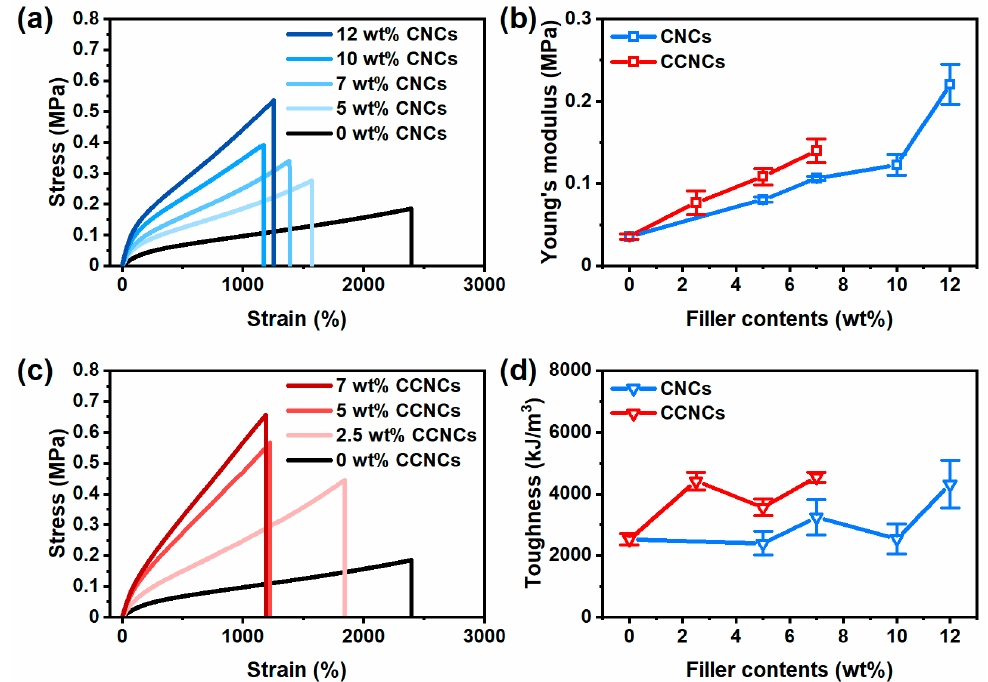
Figure 4. Mechanical properties of the nanocomposite hydrogels. ( a ) Tensile stress–strain curves of the hydrogels with different concentrations of CNCs. ( b ) The effect of different nanocrystals on the Young’s moduli of the nanocomposite hydrogels, CNCs (blue) and CCNCs (red). ( c ) Tensile stress–strain curves of the hydrogels with different concentrations of CCNCs. ( d ) The effect of different nanocrystals on the toughness of the nanocomposite hydrogels, CNCs (blue) and CCNCs (red).